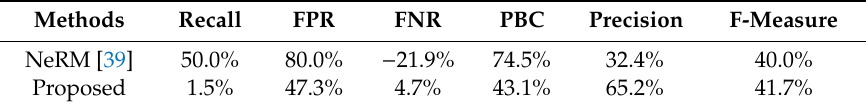
Table 5. Comparisons of improvement ratio of GMM.